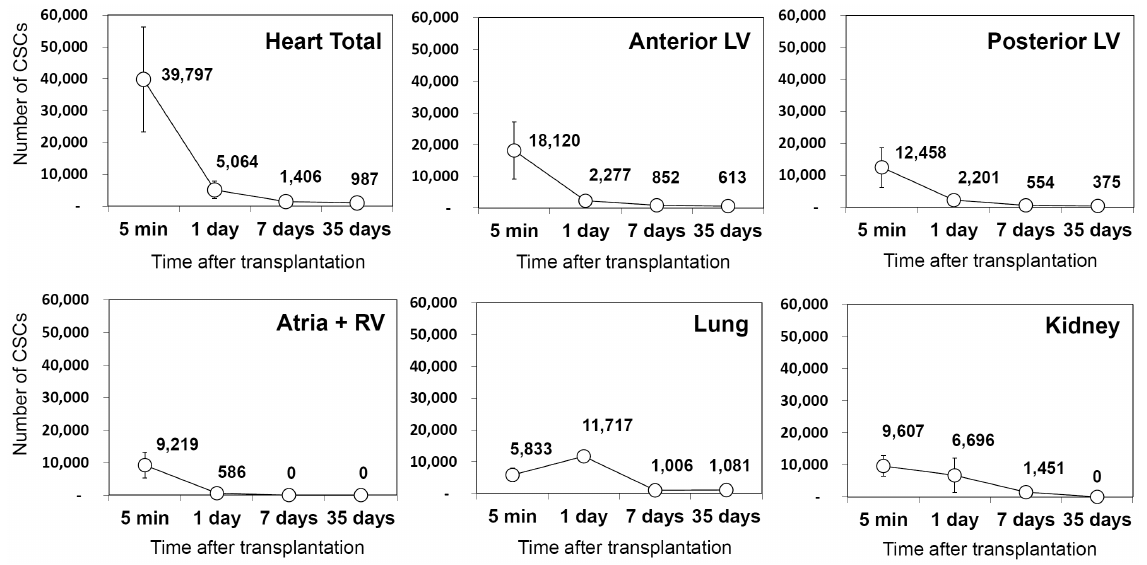
Figure 2. Distribution and retention of CSCs in various organs of the recipient mice. Values are means 6 SEM. CSCs could not be detected in liver and spleen samples at any time point examined. n=4 for the first three time points and n=7 for the 35 days group.